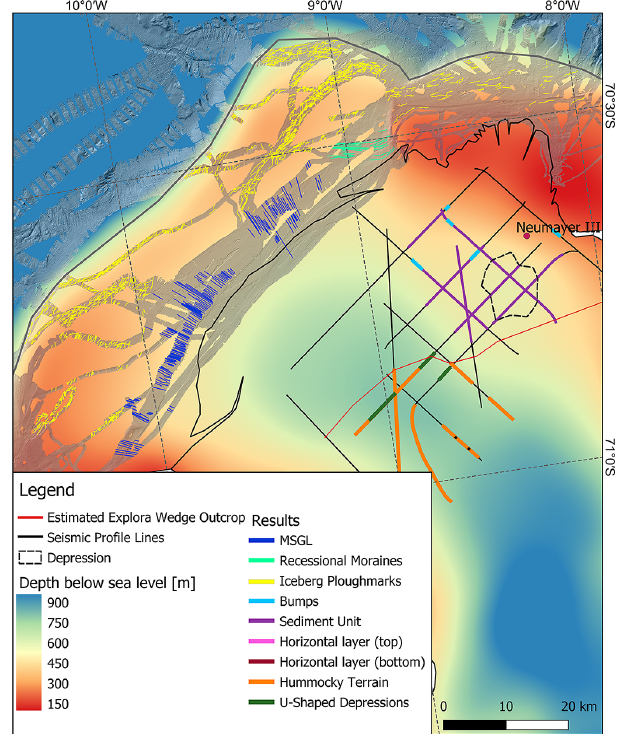
Figure 7. Overview map of the identified landforms. The length of the individual coloured lines corresponds to the detected extent of the landform in the seismic data. The ice-shelf front (thin black line) is located 25km south of the continental shelf edge (grey